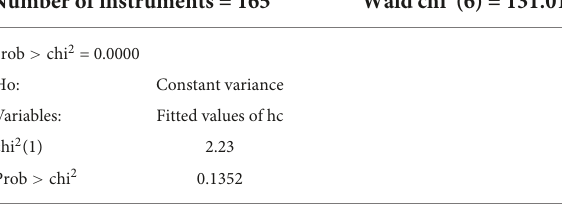
TABLE 7 Breusch-Pagan/Cook-Weisberg test for heteroskedasticity.